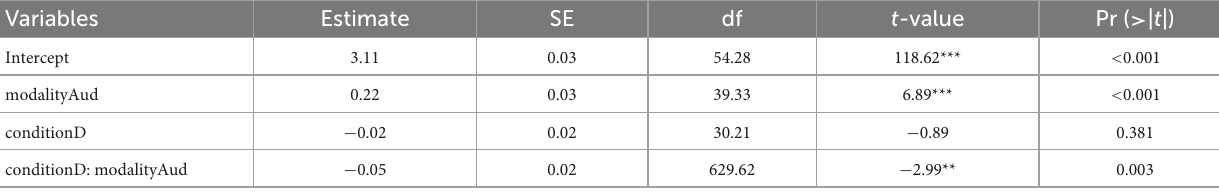
TABLE 7 Results of LME model analysis of reaction times in the translational congruency